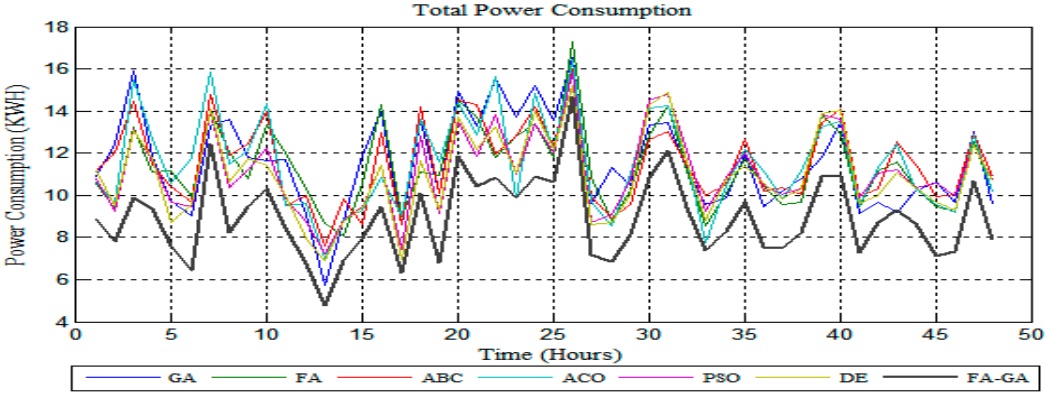
Figure 15. Total power consumption based on the considered approaches.